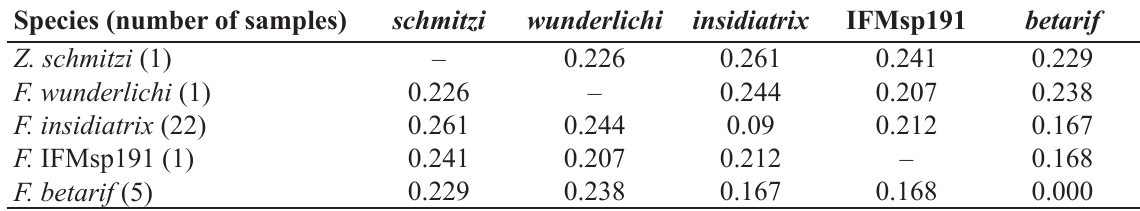
Table 2. Average pairwise genetic distances (estimated using the Kimura two-parameter model) among cytochrome c oxidase subunit I sequences of species analysed in this study. The diagonal represents average intraspecific distances (a dash indicates a single individual was sequenced for